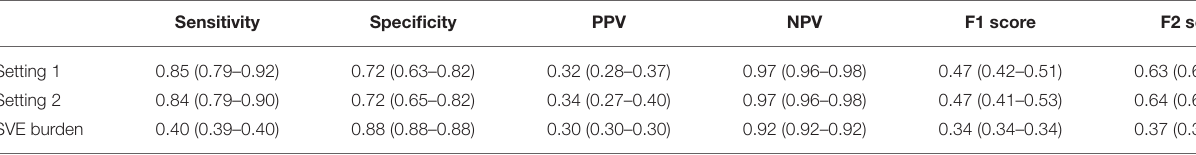
TABLE 1 | Performance evaluation of our artificial intelligence model for settings 1 and 2.